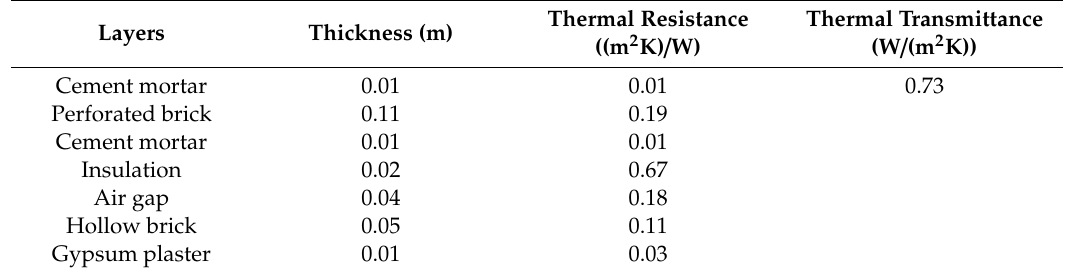
Table 1. Thermal properties of the façade layers of the building.